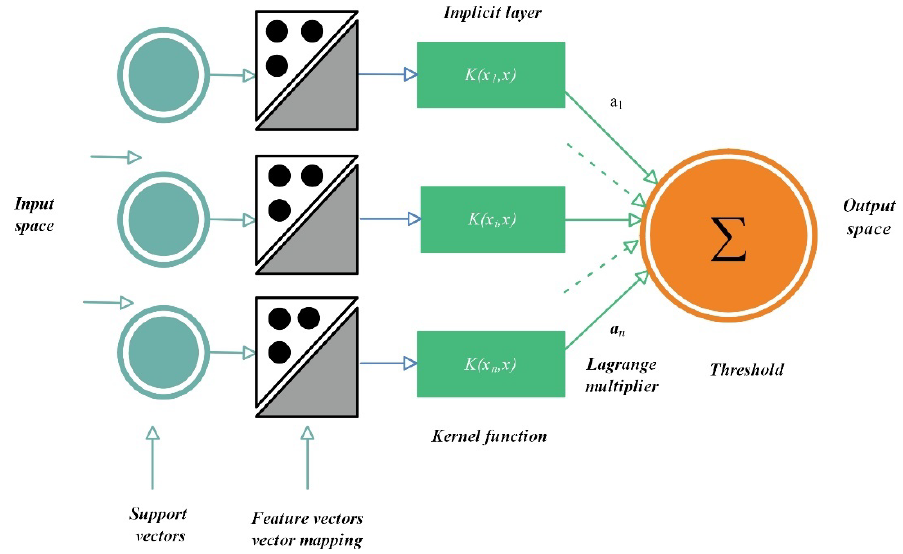
Figure 3. Structure of the support vector machine (SVM).